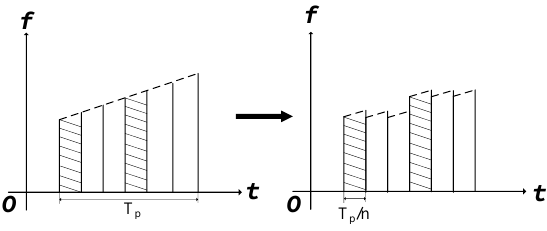
Figure 1. The principle of ISRJ.